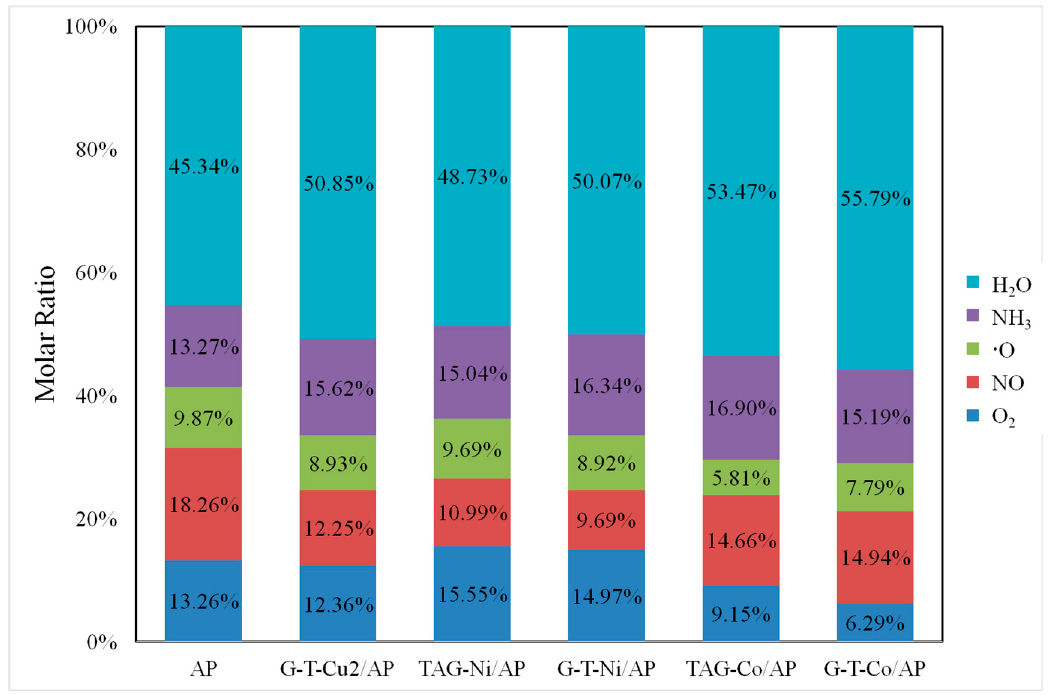
Figure 3. Comparison of molar ratio of gas products decomposed by AP coated with different TAG-M based catalysts.